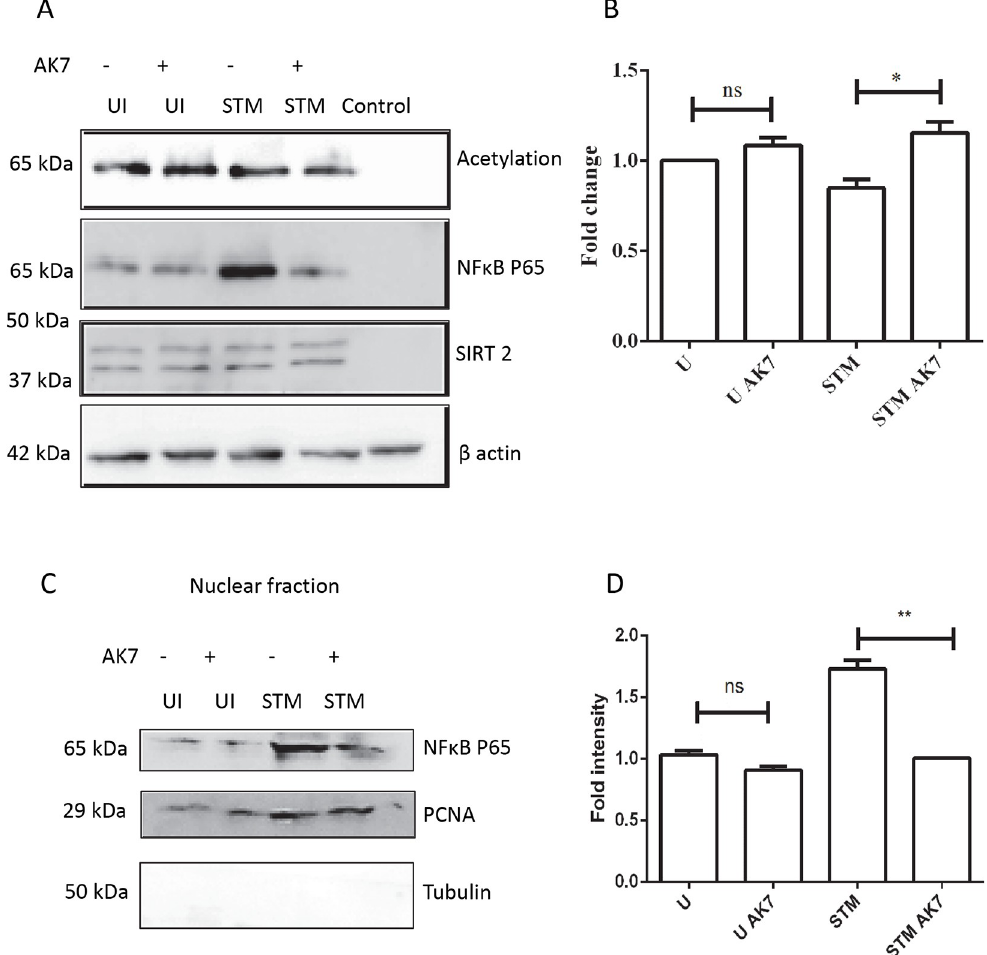
Fig 5. SIRT2 modulates p65 translocation to the nucleus. A. Representative immunoblot of SIRT2 co-IP, probed for NF κ B p65 and acetylation in the presence and absence of SIRT2 inhibition at 20 h post infection. (UI- uninfected DCs, UI AK7- Uninfected DCs treated with 10 μ M AK7, STM- Salmonella Typhimurium infected DCs, STM AK7- Salmonella Typhimurium infected DCs treated with 10 μ M AK7, Control- Isotype control) (SIRT2 +/+ DCs were used for the purpose of this experiment). B. Densitometry analysis of immunoblot of SIRT2 co-IP, probed for NF κ B p65 and acetylation in the presence and in absence of SIRT2 inhibition at 20 h post infection. (UI- uninfected DCs, UI AK7- Uninfected DCs treated with 10 μ M AK7, STM- Salmonella Typhimurium infected DCs, STM AK7- Salmonella Typhimurium infected DCs treated with 10 μ M AK7) (Data are presented as mean ± SEM of 3 independent experiments) C. Representative immunoblot of NF κ B p65 and PCNA in nuclear isolate. (UI- uninfected DCs, UI AK7- Uninfected DCs treated with 10 μ M AK7, STM- Salmonella Typhimurium infected DCs, STM AK7- Salmonella Typhimurium infected DCs treated with 10 μ M AK7) D. Densitometry analysis of immunoblots of NF κ B p65 and PCNA in nuclear isolate. (UI- uninfected DCs, UI AK7- Uninfected DCs treated with 10 μ M AK7, STM- Salmonella Typhimurium infected DCs, STM AK7- Salmonella Typhimurium infected DCs treated with 10 μ M AK7) (Data are presented as mean ± SEM of 3 independent experiments). (unpaired two-tailed Student’s t-test, p-value, ��� < 0.0001, �� < 0.001, � < 0.01).